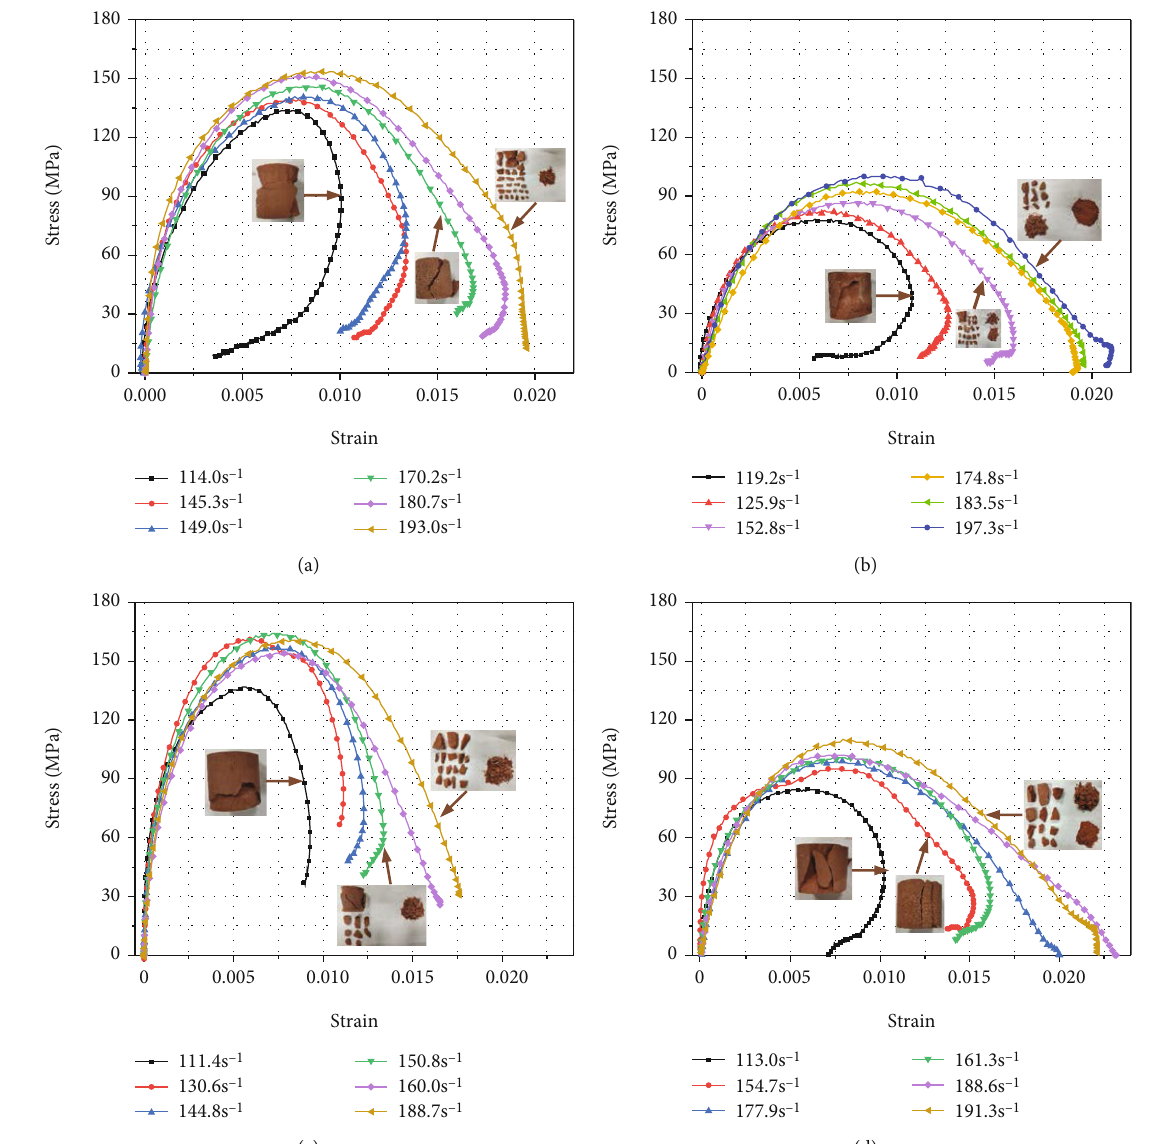
Figure 7: Dynamic stress-strain curves of (a) dry unfrozen, (b) saturated unfrozen, (c) dry frozen, and (d) saturated frozen specimens under di ff erent strain